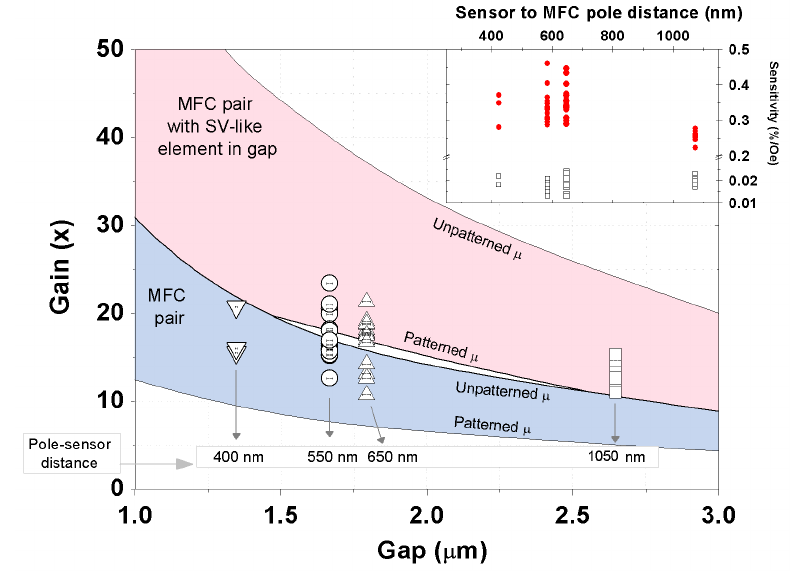
Figure 5. Experimental sensitivity gains obtained for all 47 measured devices, showing the dispersion of the results for each fabricated gap. Error bars in XX axis represent the deviations from the nominal gap size accessed by SEM. Full black line displays the trend obtained for the field gain by FEM simulations. Inset: Sensitivity values obtained for the isolated nanoSVs (black squares) and full devices (red dots) for all measured